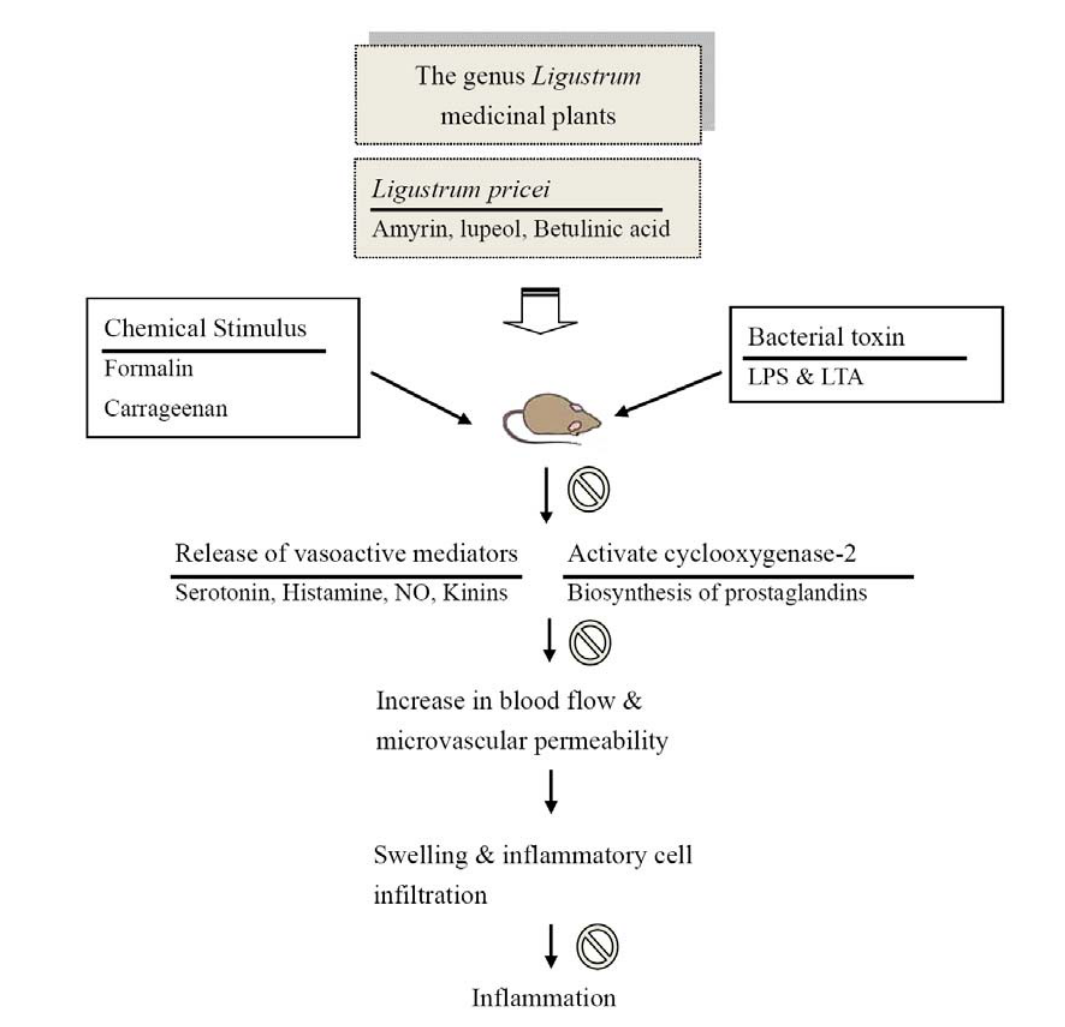
Figure 7. The proposed biological action of Ligustrum plants, especial Ligustrum pricei, as a potential anti-inflammatory plant. Prohibition sign indicates that the inhibitory effect of Ligustrum pricei